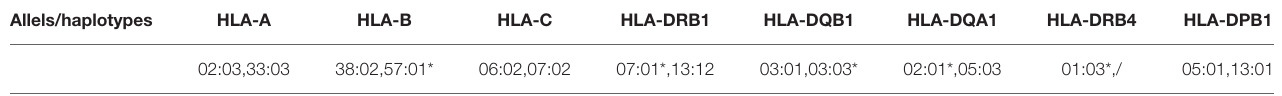
TABLE 2 | Result of Patient 2’s HLA genotyping.